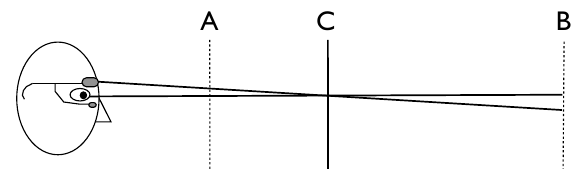
Figure 8. Parallax error at different distances. If the calibration occurs along plane C, then this offset would be corrected at other points along plane C, but would not be sufficiently corrected at closer depths (plane A) and would be overcorrected at farther depths (plane B).